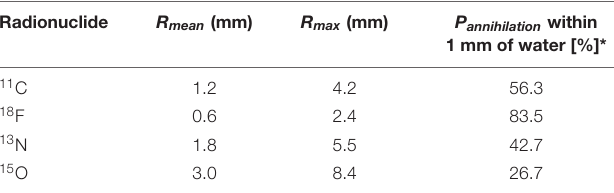
TABLE 4 | Mean and maximum positron range ( R mean and R max , respectively) of radionuclides commonly used in plant science along with the probability of annihilation ( P annihilation ) within 1 mm of